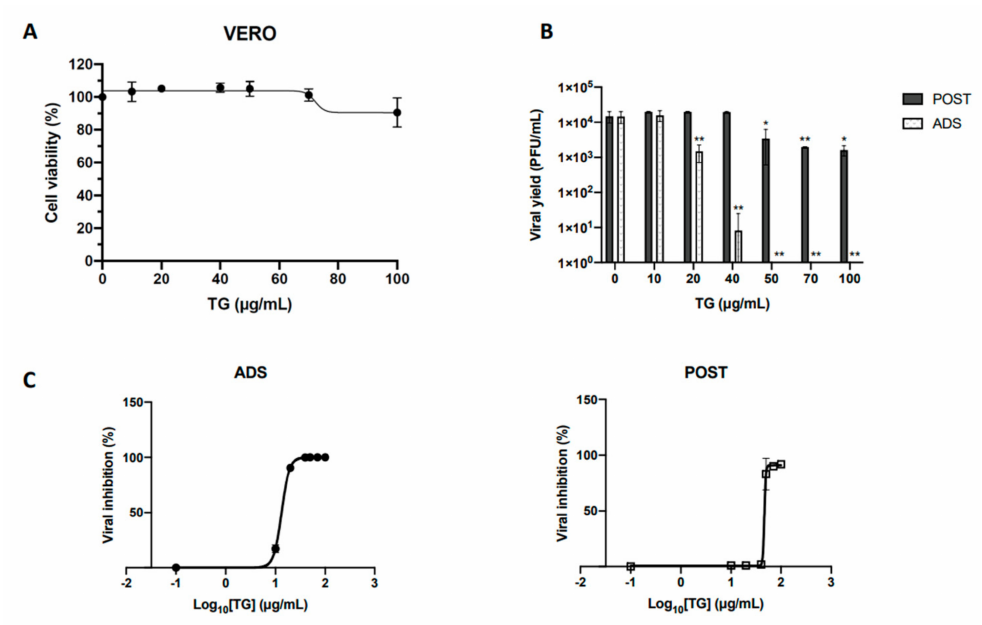
Figure 1. Effects of TG on HSV1 replication in Vero cells. ( A ) Cell monolayers were incubated for 24 h with increasing concentrations of the compound, and cell proliferation was determined by an MTT assay. ( B ) Increasing concentrations of TG (from 0.1 to 100 µ g/mL) were added to Vero cells during viral adsorption to host cells [ADS] or after viral adsorption for the following 20 h [POST], and untreated HSV-1-infected cells were used as a comparative control. HSV-1 titers were calculated by a plaque reduction assay and expressed as PFU/mL. ( C ) The antiviral (IC50) effects of TG against HSV-1 were calculated by regression analysis for the ADS (left) and POST (right) conditions. Data are expressed as mean values ± the SD from three independent experiments, each performed in duplicate (*, p < 0.05; **, p < 0.01; versus the untreated sample; unpaired t